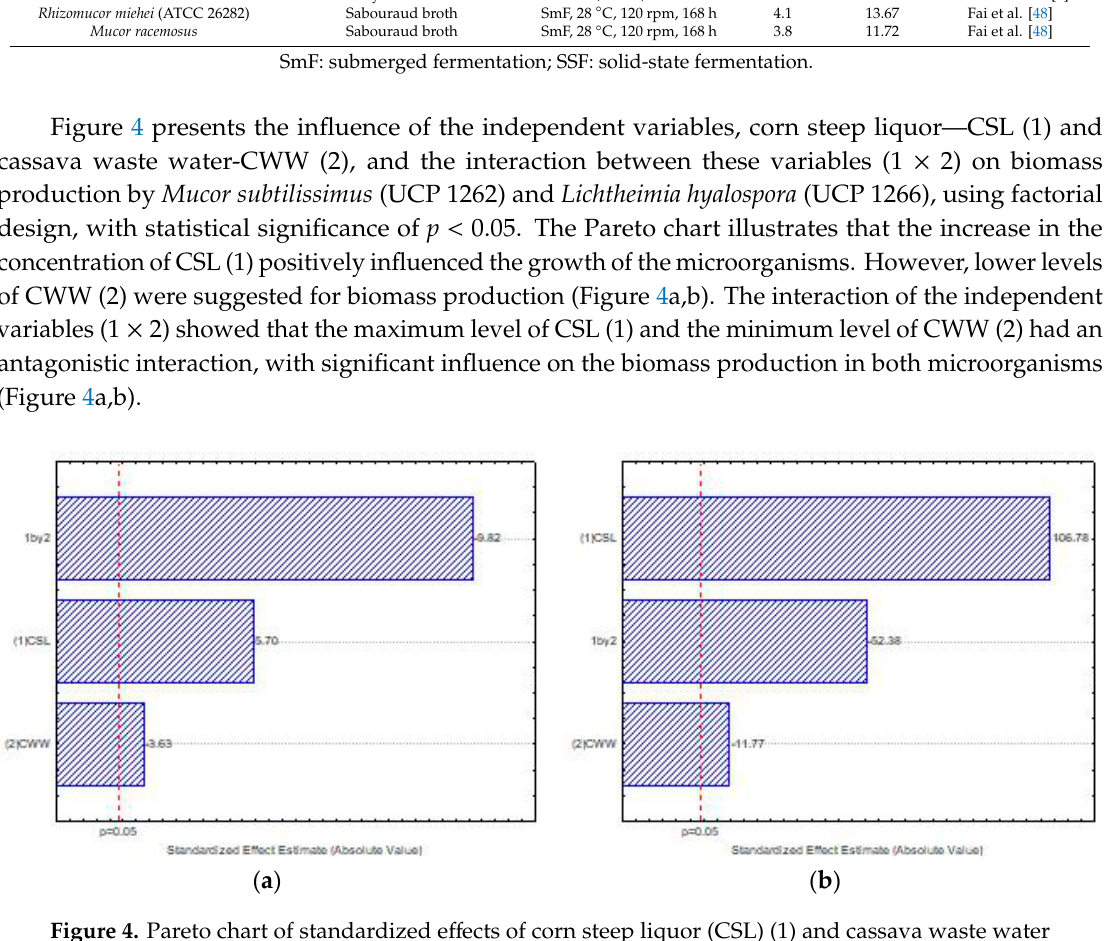
Figure 4. Pareto chart of standardized effects of corn steep liquor (CSL) (1) and cassava waste water (CWW) (2) on the biomass production by Mucor subtilissimus (UCP 1262) ( a ) and Lichtheimia hyalospora (UCP 1266) ( b ).